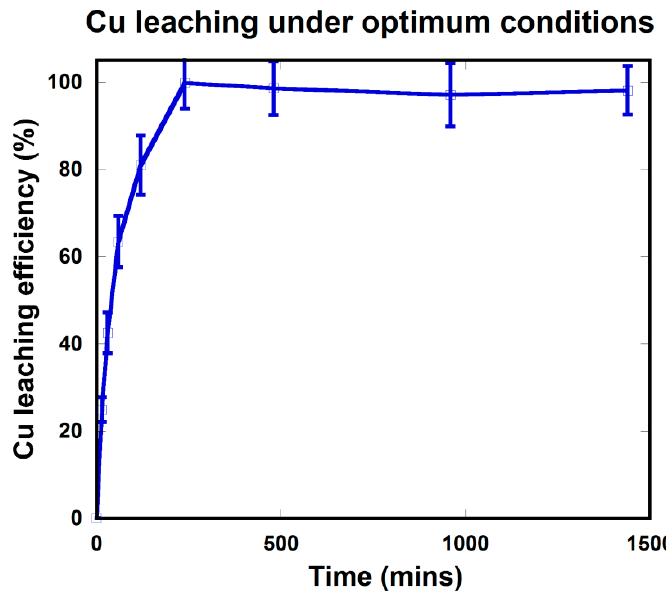
Figure 5. Leaching of Cu from PCBs under optimum conditions.